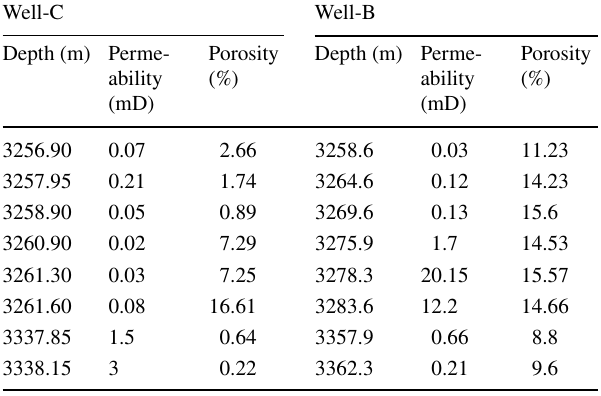
Fig. 4 Workflow of the method- ology used in this study